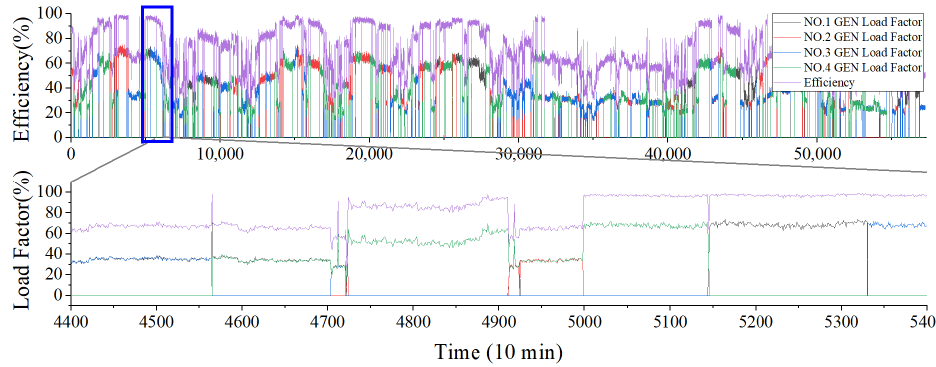
Figure 5. Generator load factor and efficiency during operation.